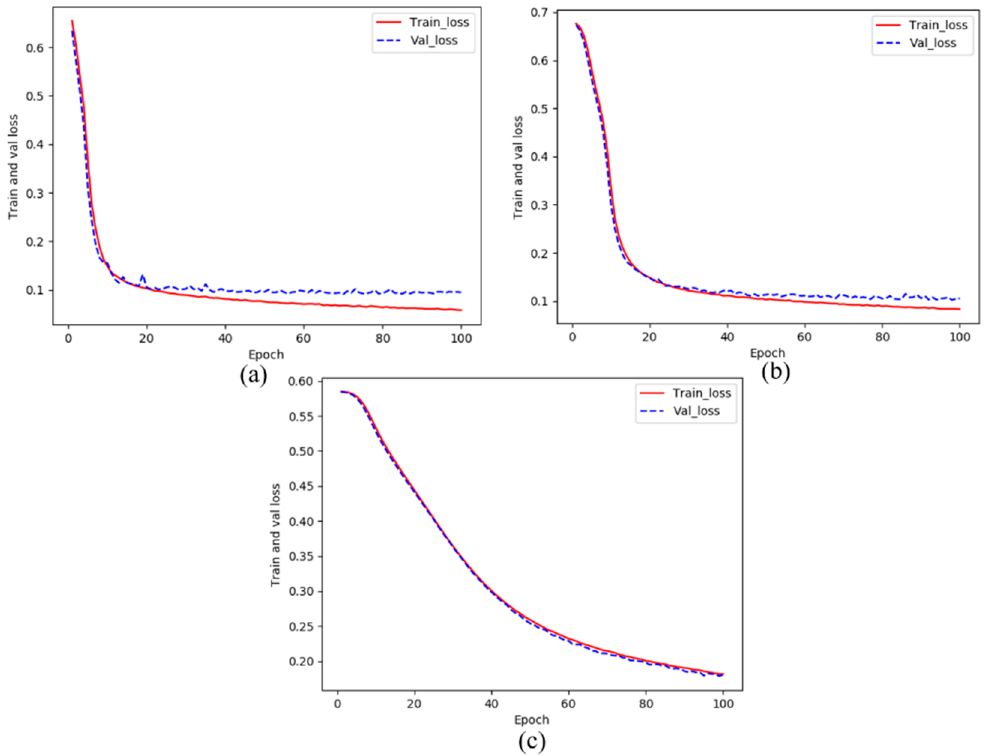
Figure 9. The training losses and validating losses over training epoch: ( a ) learning rate = 10 − 4 , ( b ) learning rate = 10 − 5 , ( c ) learning rate = 10 − 6 .